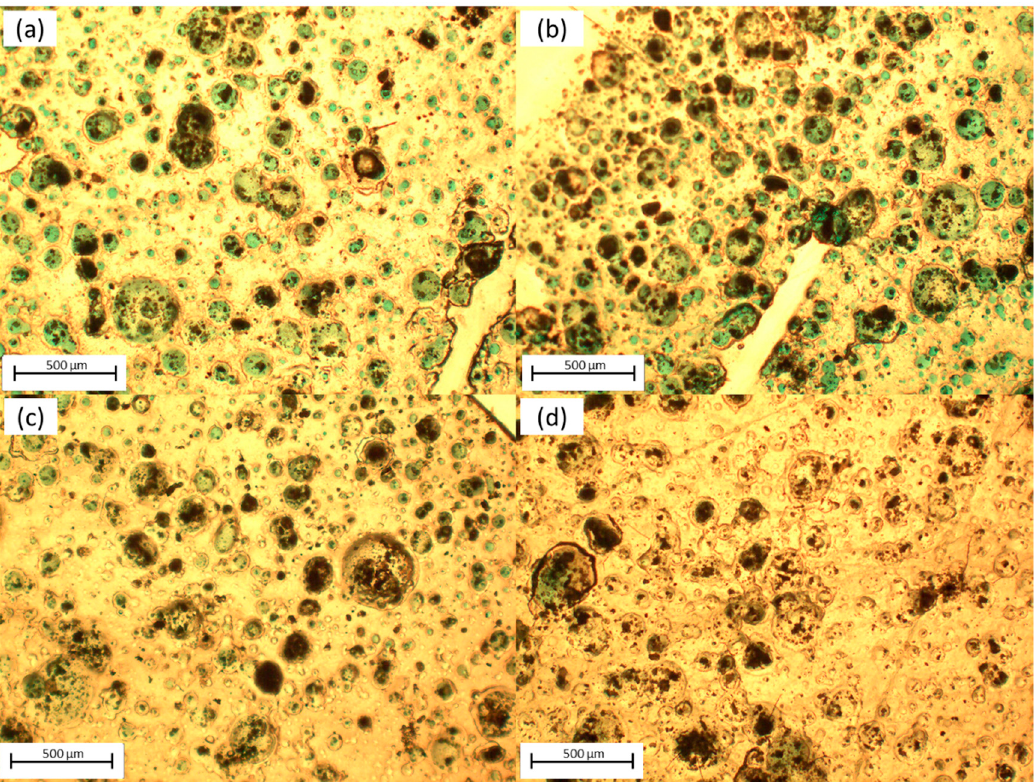
Figure 3. OFET optical characterization under normal light conditions. ( a ) Region 1; ( b ) Region 2; ( c ) Region 3; ( d ) Region 4.